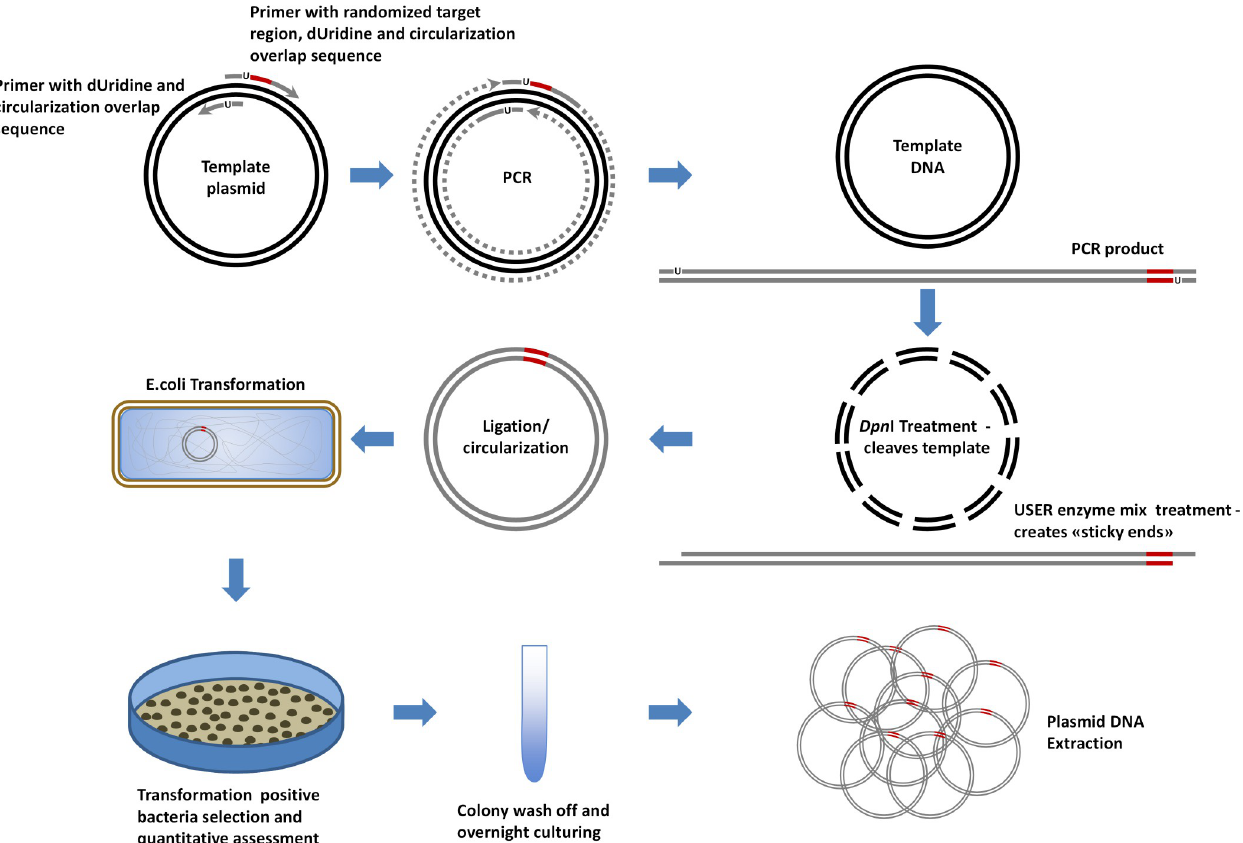
Fig 1. Randomization was carried out by employing a modified whole plasmid amplification (WPA) strategy, where we utilized 1) one long reverse strand oligonucleotide (starting from the 3’ end, it contained a sequence complementary to plasmid DNA, a randomized region (represented by the red line), a stop codon, and additional sequence where the first thymidine was replaced with deoxyuridine (represented by U)), 2) one short forward strand oligonucleotide (starting from the 3’ end, it contained a sequence complementary to plasmid DNA and a sequence complementary to the reverse primer’s 5’ nucleotides (here, also, the first thymidine was replaced with deoxyuridine)), and 3) high fidelity polymerase (Phusion U) which tolerates uridine. Following amplification, the reaction mixture was treated with Dpn I restriction enzyme, which cleaves only methylated (bacterial origin) DNA, and USER (Uracil-Specific Excision Reagent) enzyme mix, which excises the uridine base from amplification products and cleaves abasic sites, thus forming a ‘sticky end’. The amplification product was then circularized and transformed into competent E . coli Dh5 α strain cells, which were seeded onto an ampicillin-supplemented LB media petri dish and incubated overnight at 37˚C. The next day, transformation positive colonies were quantified, washed off, inoculated in ampicillin-containing liquid media, and following overnight culturing, used to extract randomized plasmid DNA. The grey, dotted, and dashed lines represent the synthesized chain, DNA synthesis, and template DNA degradation by Dpn I restriction endonuclease, respectively.